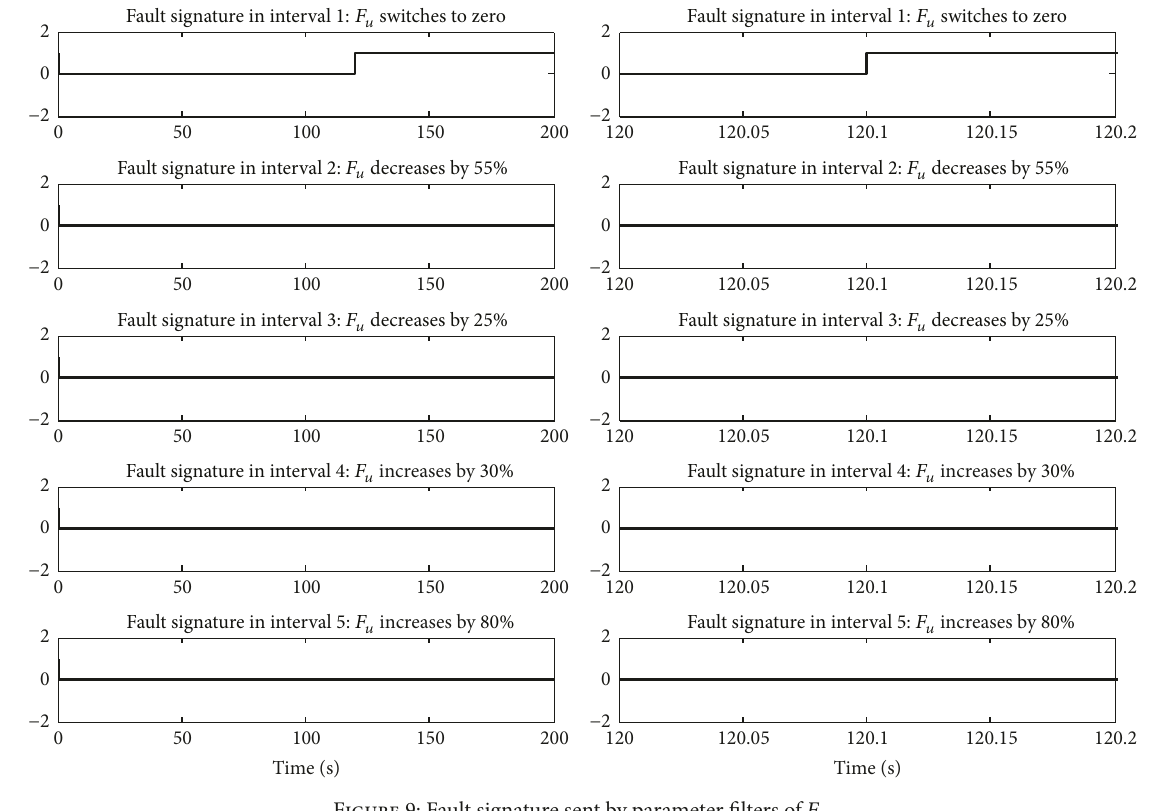
Figure 9: Fault signature sent by parameter filters of 𝐹 𝑢 .